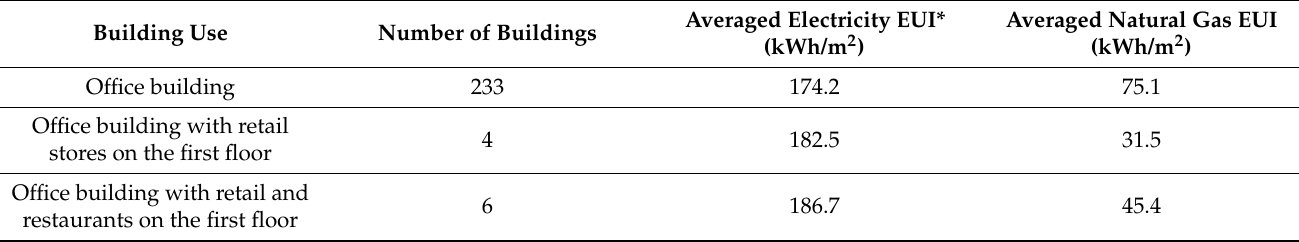
Figure 9. The distribution of energy use intensity with periods. Table 9. The energy use intensity of specific building